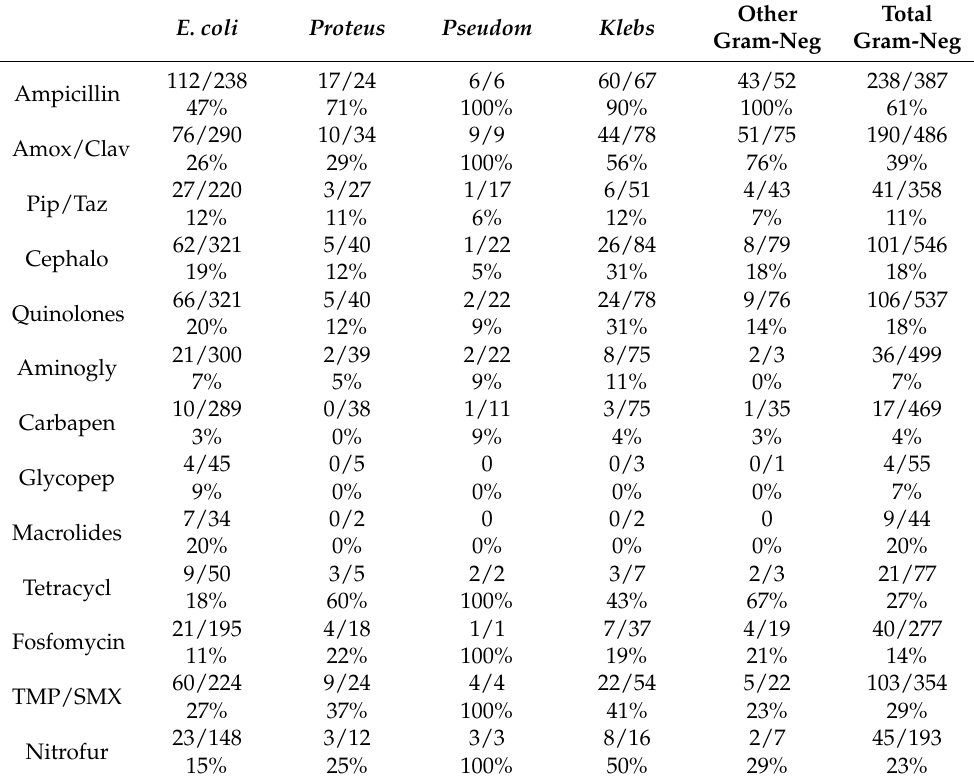
Table 1. Resistance rates of Gram-negative